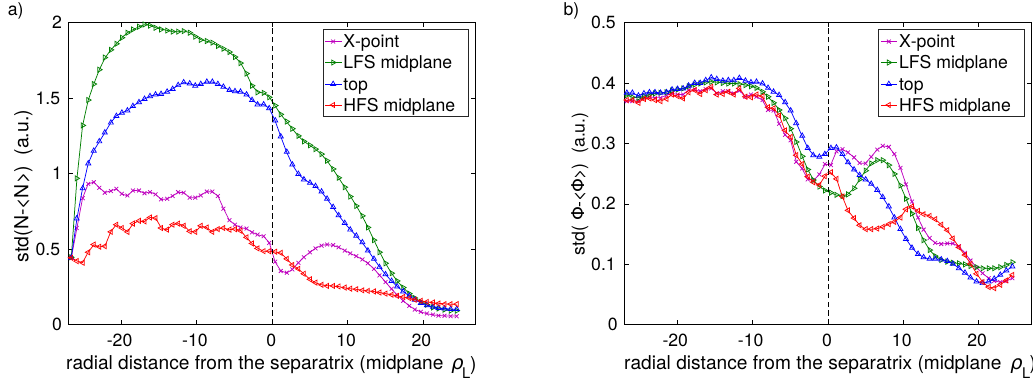
Figure 7. ( a ) Radial profiles of the standard deviation of density fluctuations, plotted at different poloidal position. ( b ) Same plot for the electrostatic potential